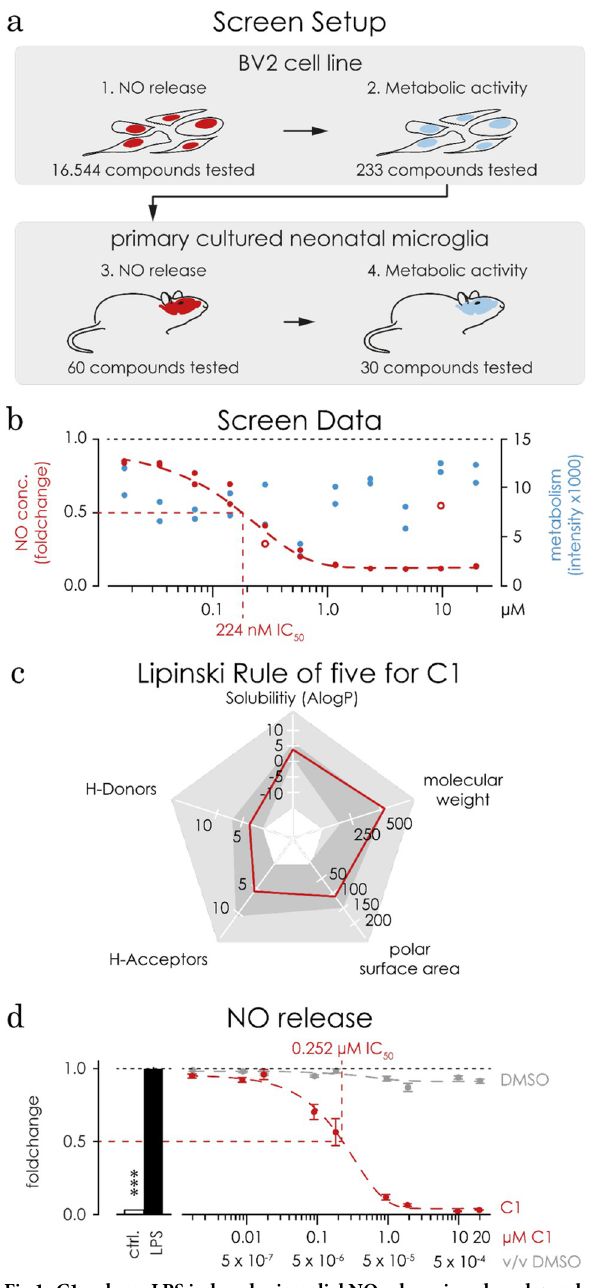
Fig 1. C1 reduces LPS induced microglial NO release in a dose dependent manner. a) Representative illustration of the HTS setup. Initially (1.), 16 544 compounds were tested for their ability to reduce LPS-induced NO-release in BV-2 cells. (2.) The best 233 compounds were tested for their impact on metabolic activity. (3.) 60 compounds passed and were further analysed in primary microglial cells. (4.) 30 out of 60 reduced LPS induced NO release, and showed no impact on metabolic activity. Out of the 30 compounds C1 was chosen and further analysed. b) The data obtained from the screen showed a dose-dependent reduction of the concentration of NO in the medium (shown in red). The calculated IC 50 value is 224 nM (vertical red dotted line). Two data points of the NO assay, marked as red open circles, were automatically excluded using a robust fit outlier model in GraphPad prism. The metabolic activity remained stable (shown in blue). c) C1 fulfils 4 of the 5 “Lipinski rule of five”, that include the number hydrogen bond donors (Lipinski � 5, C1 = 2), and the hydrogen bond acceptors (Lipinski � 10, C1 = 6), polar surface area (Lipinski 140 � Å 2, C1 = 106.2 Å 2), solubility (Lipinski � 5 AlogP, C1 = 4.7 AlogP), but is slightly beyond the limit for the molecular weight (Lipinski � 500 g/mol, C1 = 517.6 g/mol). d) Transferred to a laboratory scaled setup, primary cultured microglia were treated with C1 or DMSO for 1 hour followed by an additional stimulation with 1 μ g/mL LPS for 48